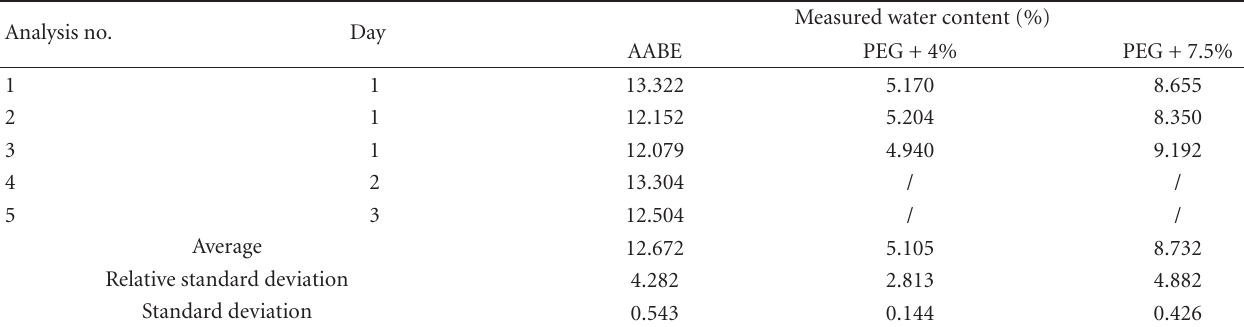
Table 1: AABE moisture determination series.